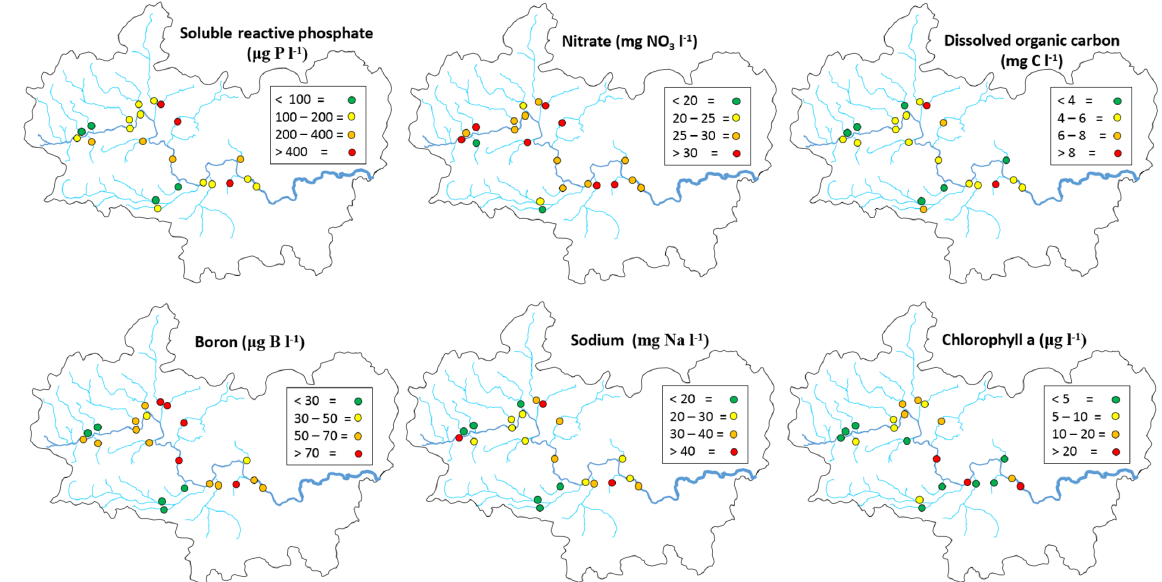
Figure 2. Spatial variation in chemical concentrations and chlorophyll a across the Thames